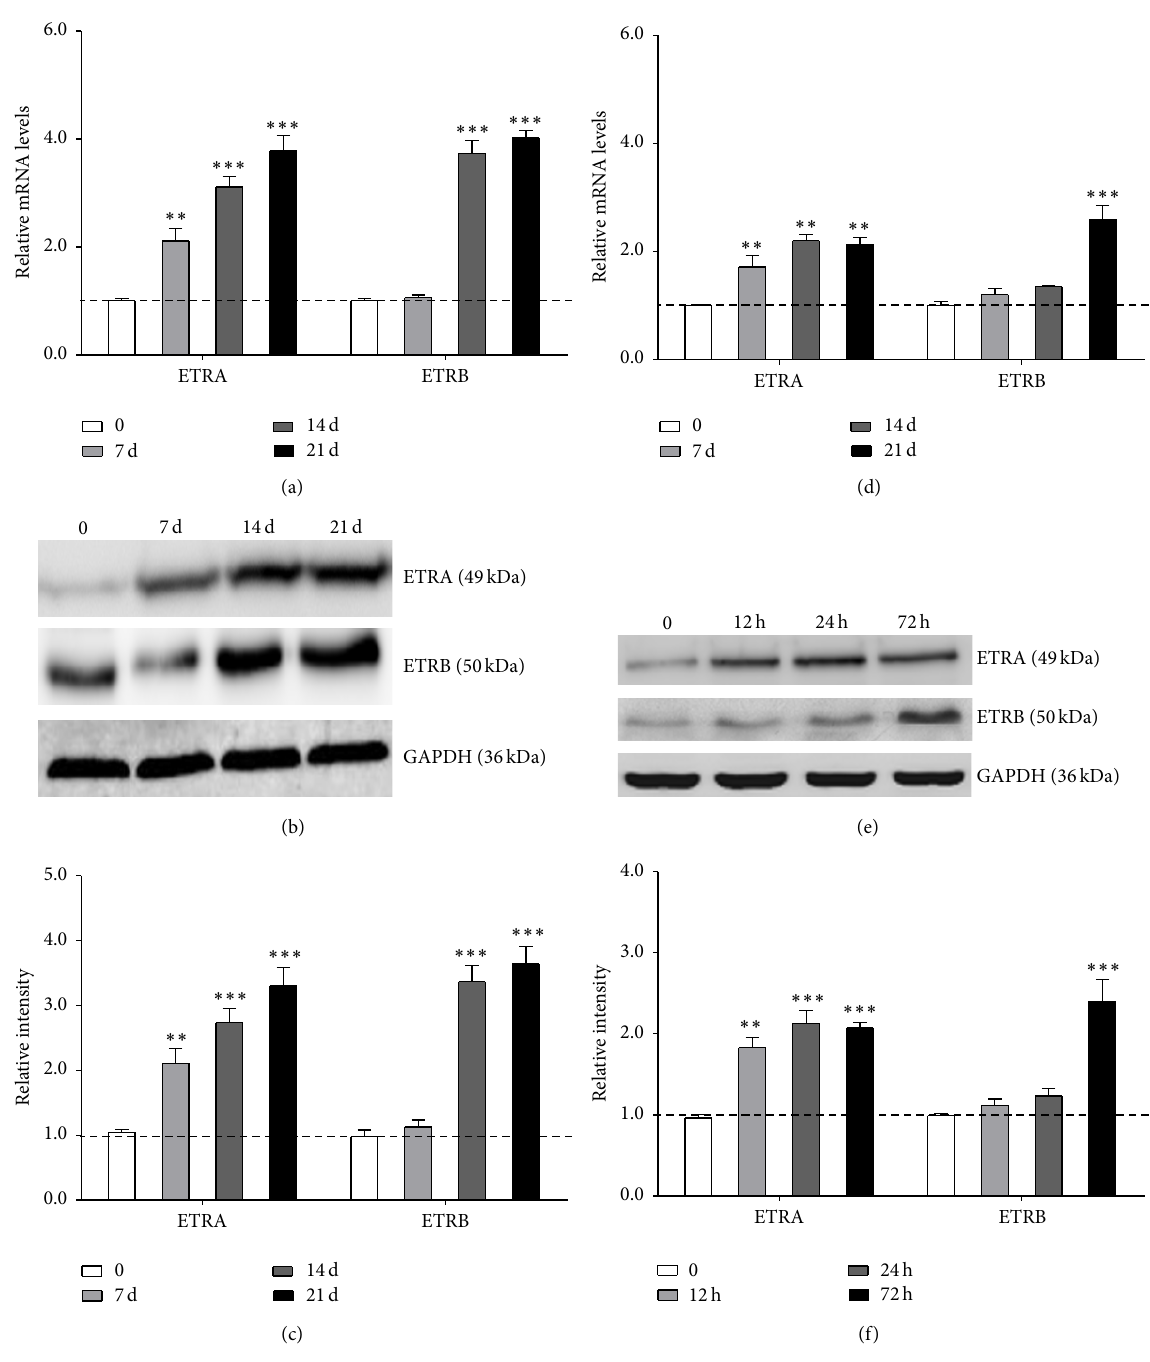
Figure 4: ET-1 promoted differentiation of PDLSCs through ETR pathway. The effect of ET-1 on ETRA mRNA expression level increased with increasing treatment time, peaking at 21d ((a) and (d)). A time-dependent increase in ETRA protein level was also observed ((b) through (f)). The stimulatory effects on ETRB mRNA and protein levels were detected. Each bar represents the mean ± standard deviation ( 𝑛 = 3 ). ∗ 𝑃 < 0.05 ; ∗∗ 𝑃 < 0.01 ; ∗∗∗ 𝑃 < 0.001 .